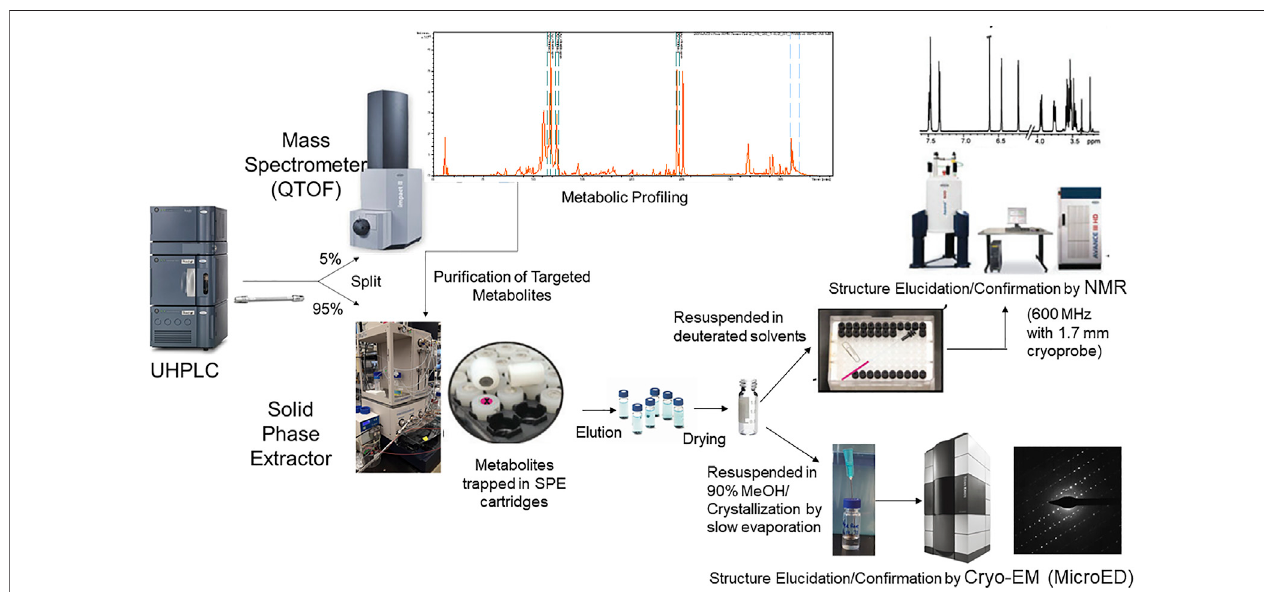
FIGURE 1 | Schematic representation of integrated analytical work fl ow (UHPLC-MS-SPE-NMR and MicroED) for automated puri fi cation and structure elucidation of targeted metabolites. The platform allows putative identi fi cation of metabolites based upon retention time, accurate mass, and MS/MS database searches. Targeted metabolites that are unidenti fi ed or require further structural con fi rmation can be puri fi ed simultaneously using the UHPLC-MS-SPE system in an automated manner. Structures of puri fi ed metabolites can then be con fi rmed or elucidated by NMR or MicroED.